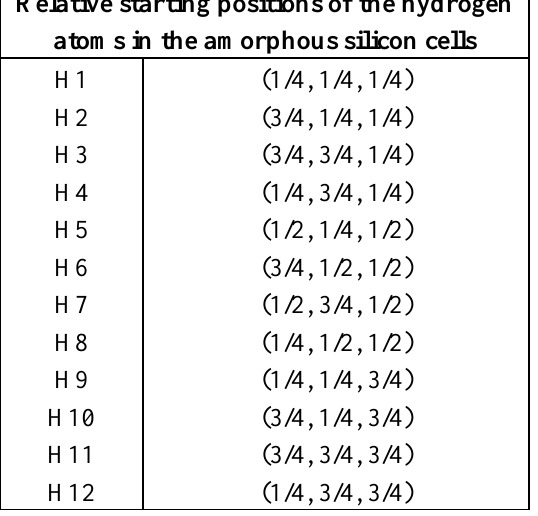
Table 1. Fractional initial positions of the 12 hydrogens placed symmetrically within the silicon